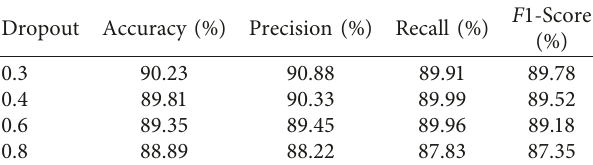
Table 2: Effect of dropout value.